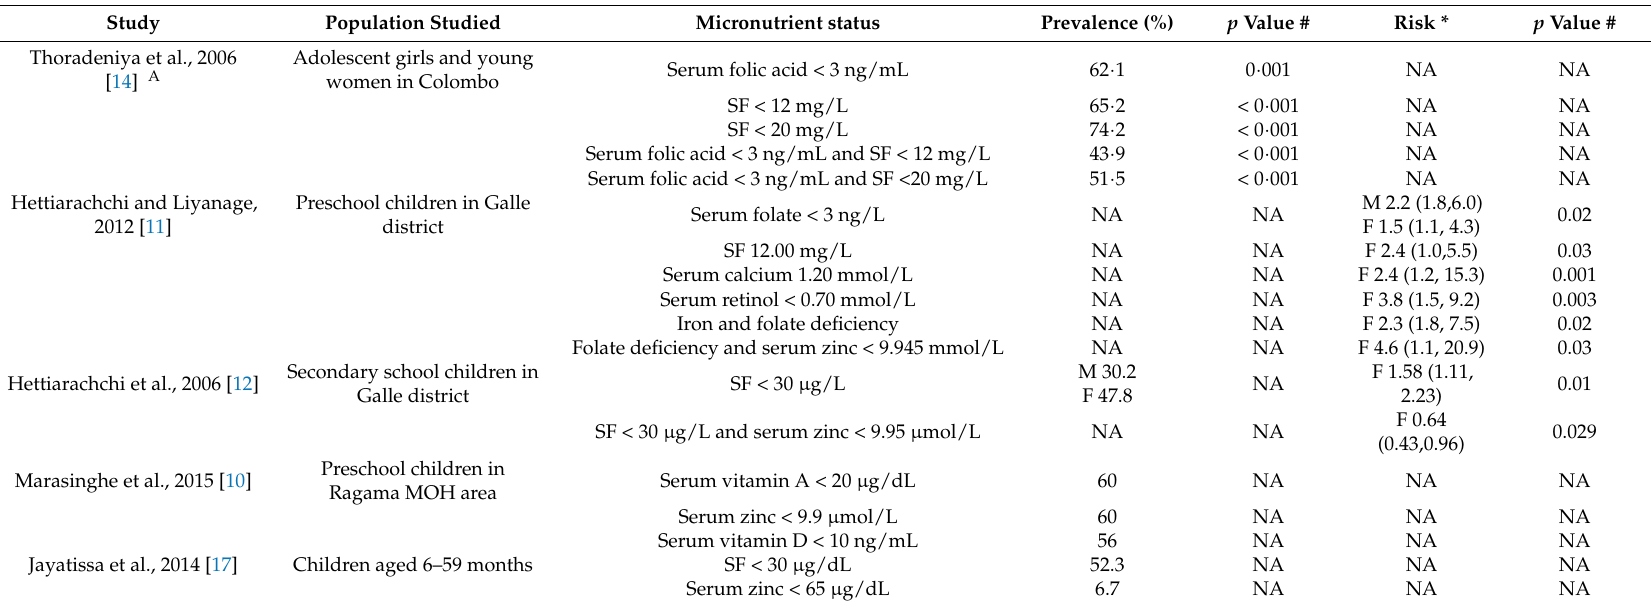
Table 9. Prevalence and risk of anemic subject having